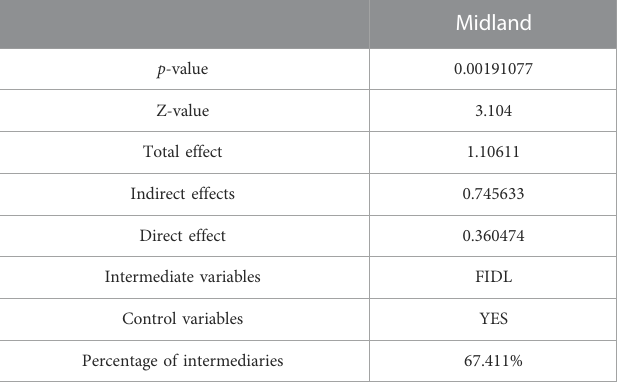
TABLE 12 Central Region results for fi nancial sector development as a mediating variable.